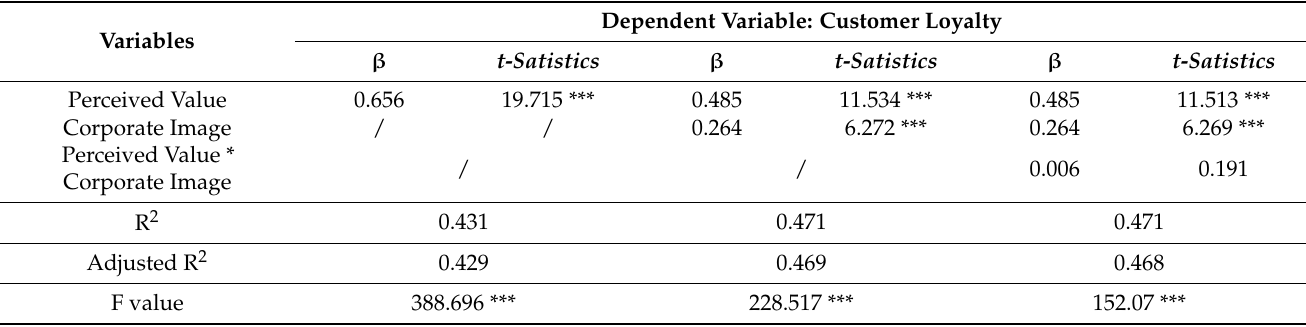
Table 7. Structural model II of the moderating effect from corporate